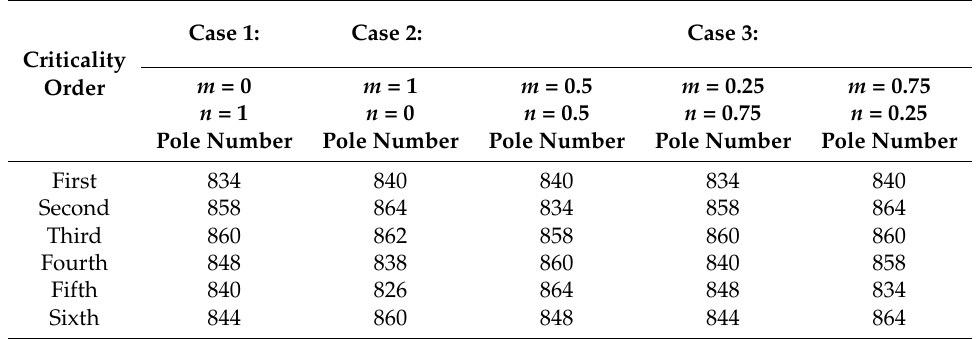
Table 3. Classification of the six most critical poles according to the performance functions of Cases 1, 2, and